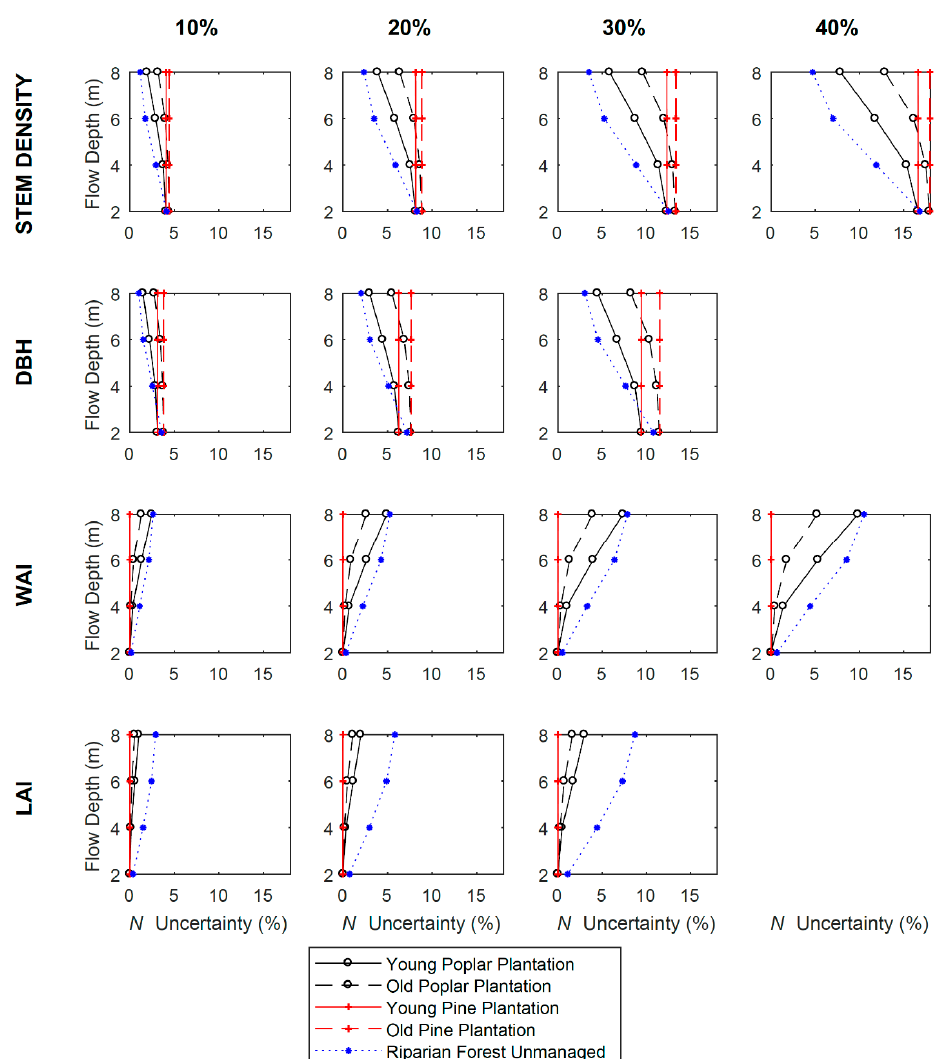
Figure 2. Sensitivity of Manning’s n roughness to error in forest structural variables by 10, 20, 30, and 40%. Forest structure variables varied are stem spacing, the diameter at breast height (DBH), the branching or Wood Area Index (WAI), and the Leaf Area Index (LAI). Sensitivity is tested over five forest types; Young and Old Poplar Plantations, Young and Old Pine Plantations, and an Unmanaged Riparian Forest.